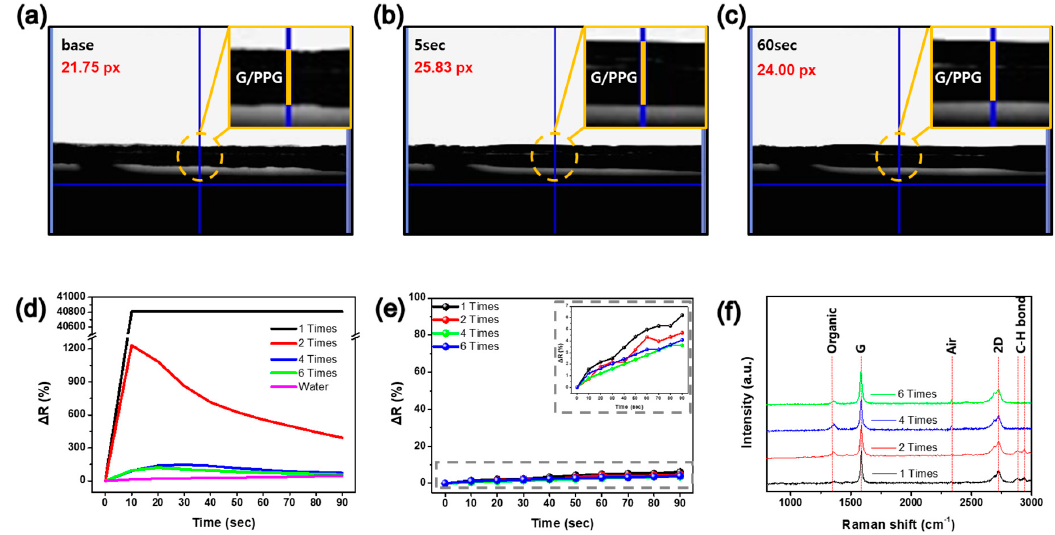
Figure 4. Swelling phenomenon of ( a ) bare, ( b ) after 5 s and ( c ) after 60 s reacted G/PPG (1:2) HC film with gasoline. ( d ) Sensitivity of sensor, ( e ) sensor stability in water, and ( f ) Raman spectra of G/PPG (1:2) HC film during cycle tests. (1:2) HC film during cycle